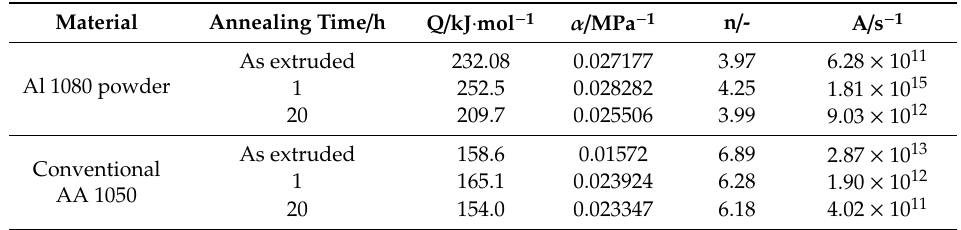
Table 4. Comparison of apparent activation energies for hot deformation and material parameters for extruded and annealed conditions for Al 1080 powder and conventional AA 1050 alloy.